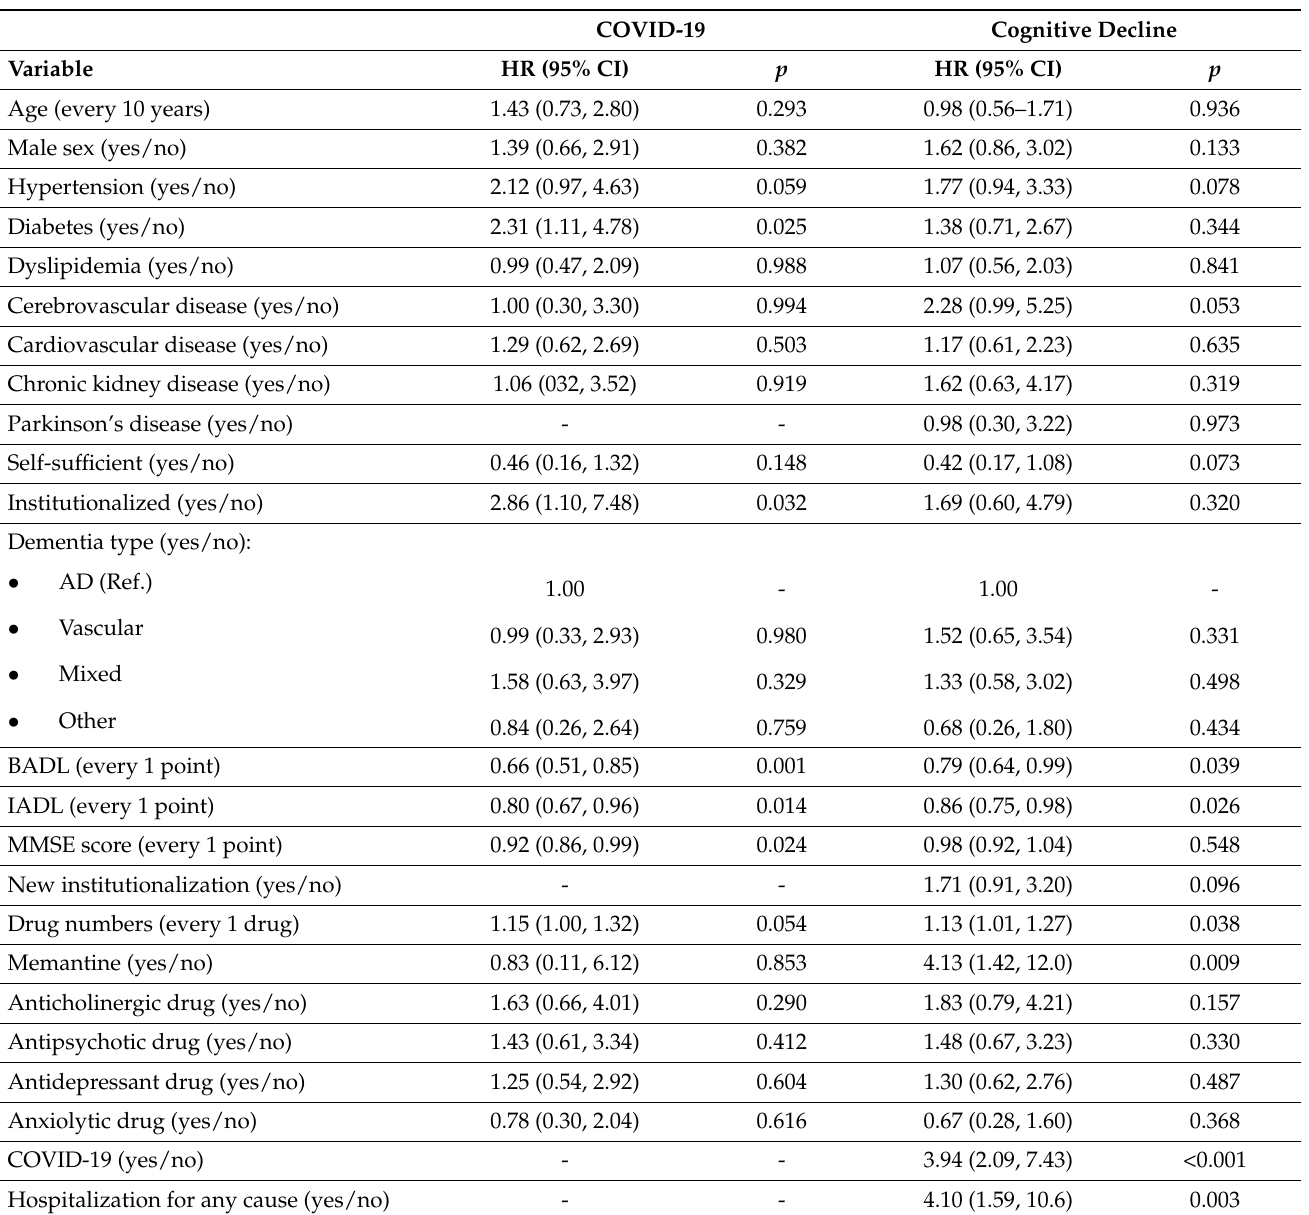
Table 3. Predictors of COVID-19 and significant cognitive decline in univariate Cox proportional hazards analysis. COVID-19 Cognitive